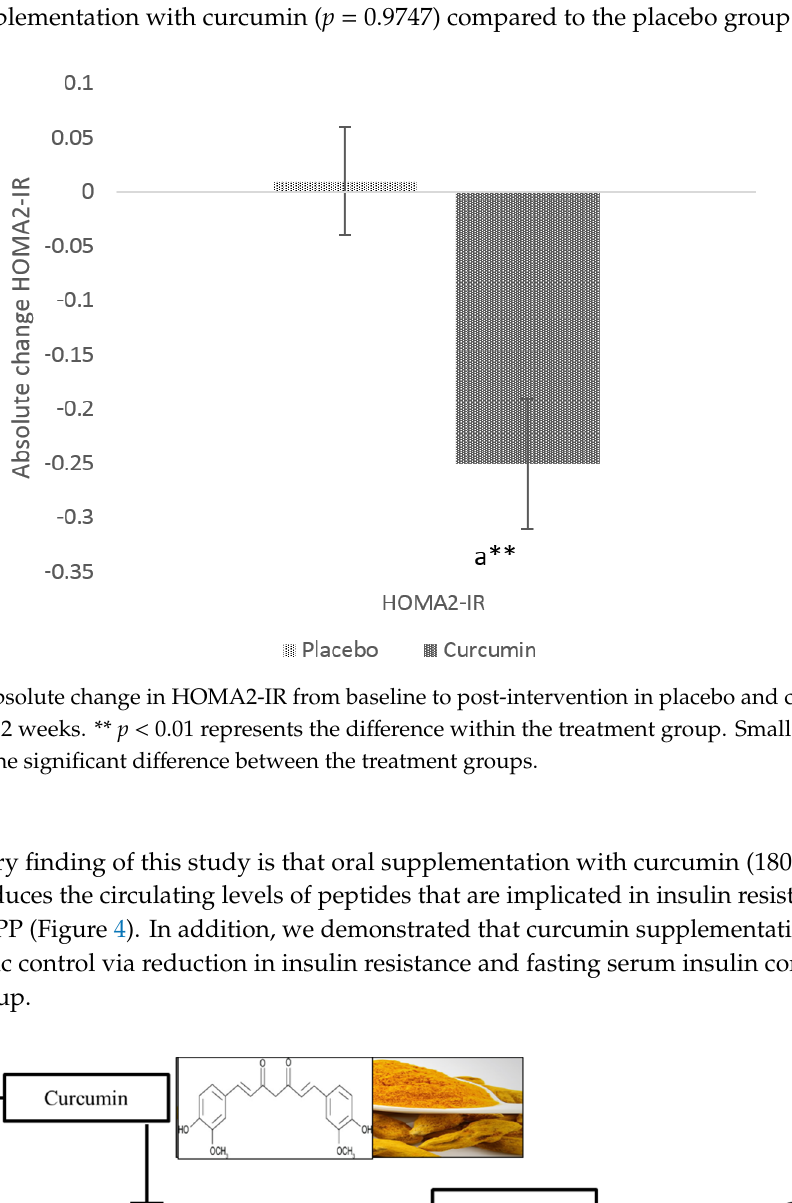
Figure 2. Absolute change in serum islet amyloid peptide (IAPP) from baseline to post-intervention in placebo and curcumin groups for 12 weeks. * p < 0.05 represents the difference within the treatment group. Small letter (a) represents the significant difference between the treatment groups.